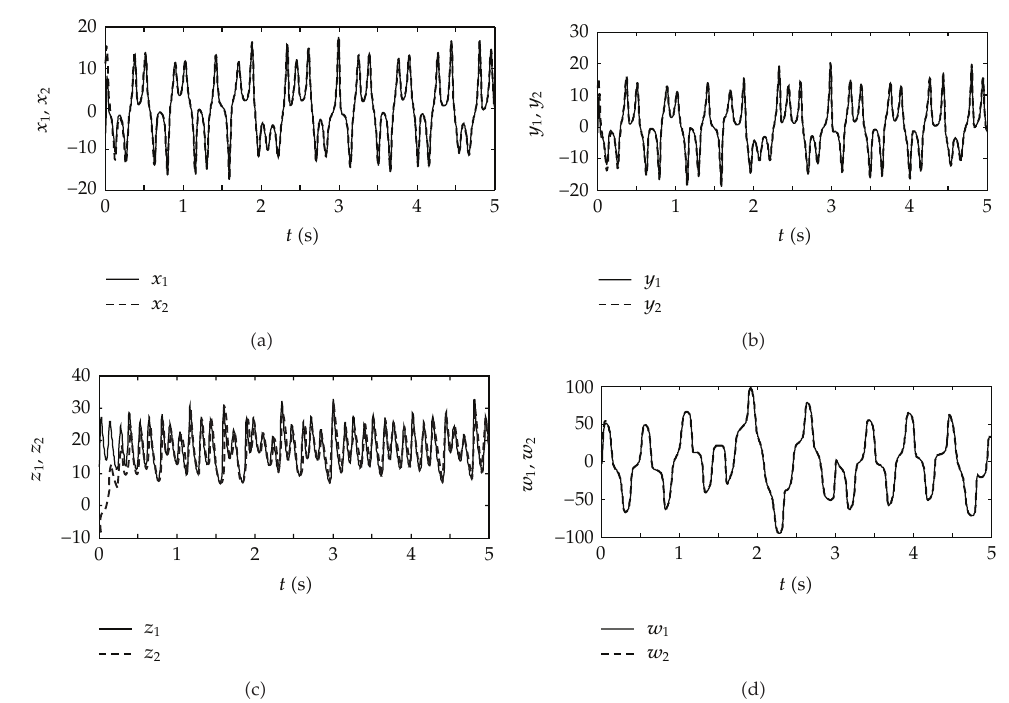
Figure 3: The synchronization of system (cid:5) 4.2 (cid:6) and system (cid:5) 4.1 (cid:6) with α (cid:7) 0 . 96: (cid:5) a (cid:6) the synchronization of x